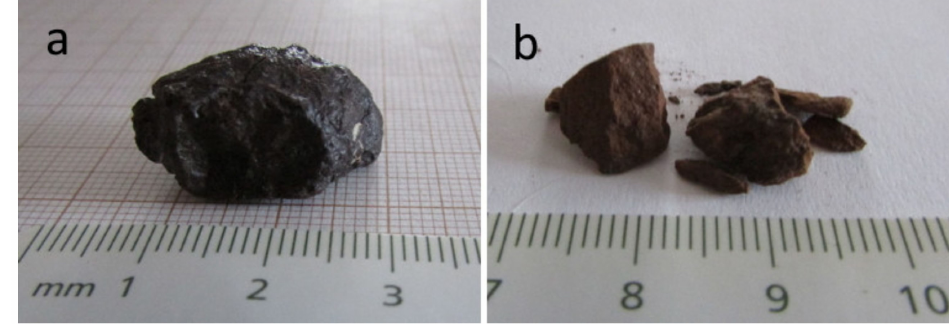
Figure 2. Typical NWA 1990 stony pieces: ( a ) a collected fragment, ( b ) crushed fragment. Several tektites from different strewn fields were studied: moldavites, indochinites (including Muong Nong type), bediasites, chinites (including Guangdong tektites), rizalites, australites and other Australasian tektites from different locals. A Darwin glass from Tasmania was also studied. The indochinites studied were from Khon Kaen (10 samples) and Norm, Khorat Plateau (Thailand, 3 samples), the bediasites from Texas (4 samples), chinites from Leigong Mo (5 samples), rizalites from the Philippines (2 samples), an australite from Lake Yindalgooda, Australia, a moldavite from Chum Sud, Bohemia, and other Australasian samples from Laos, Vietnam, Tibet and Cambodia. Among the tektites studied there were three Muong Nong-type, two from Laos and one from China. Figures 3–5 show examples of the samples.